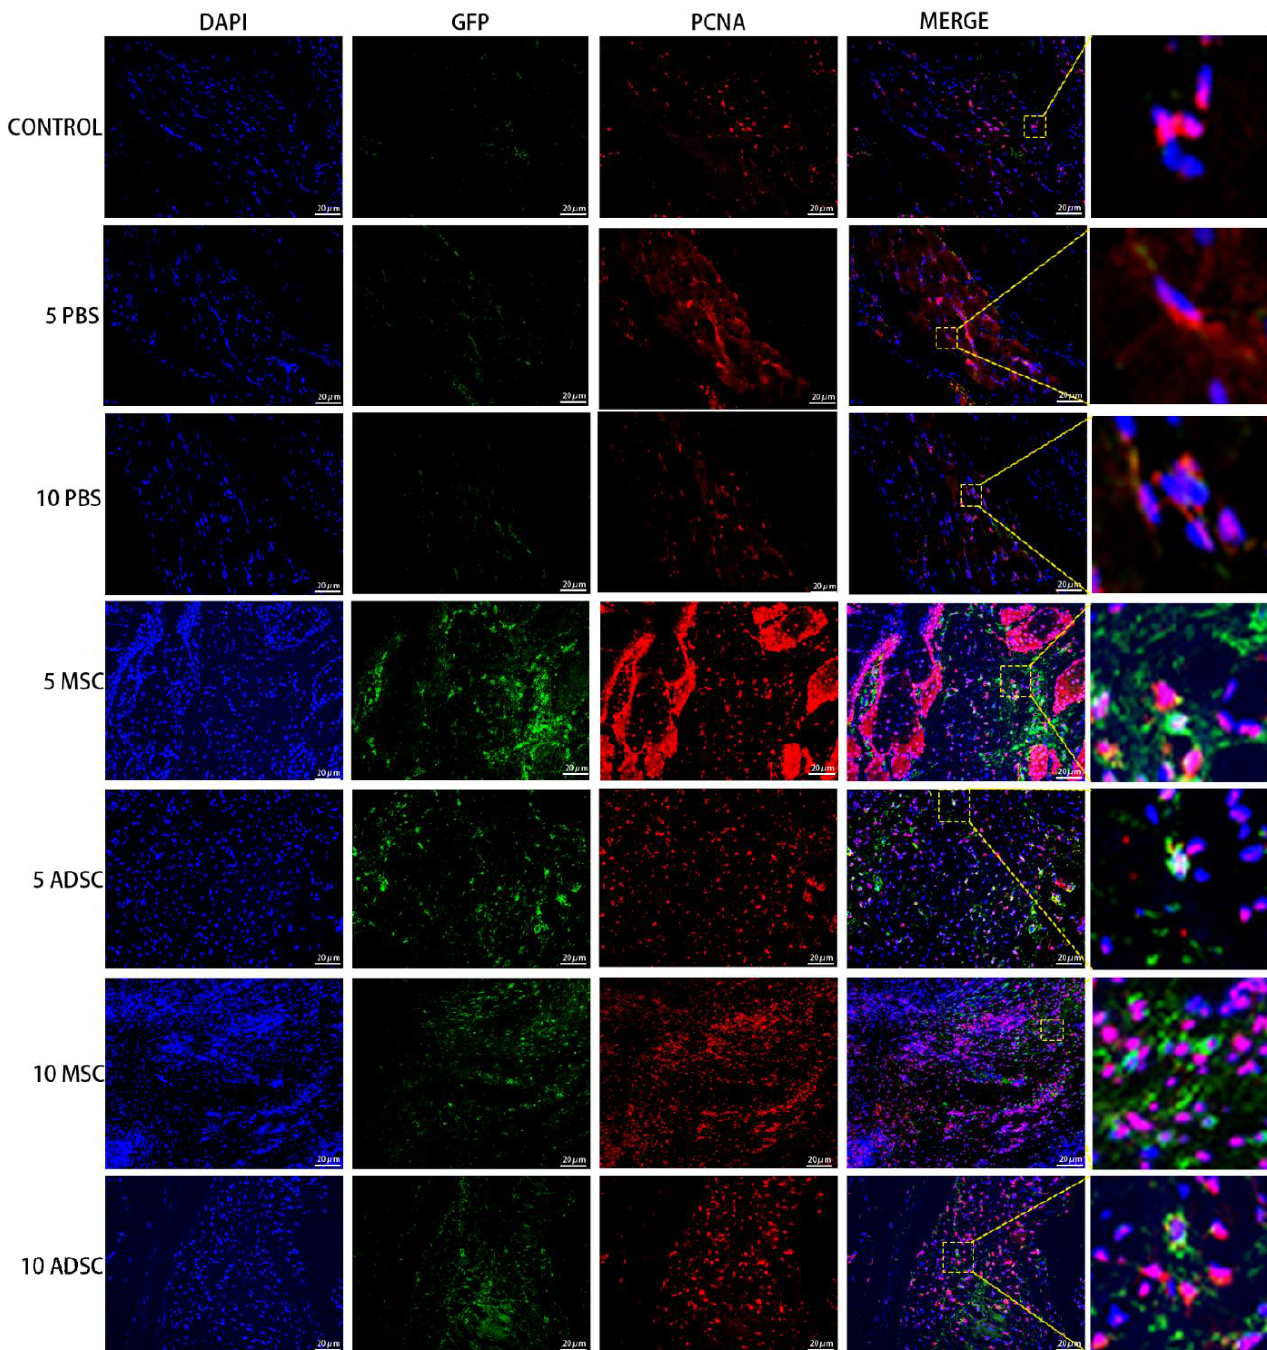
Figure 7. Fluorescence of DIL labeling after 5 and 10 days of treatment in CSVF group. Cell nucleus was stained in blue with DAPI, and DIL-labeled CSVF was visualized by red fluorescence.